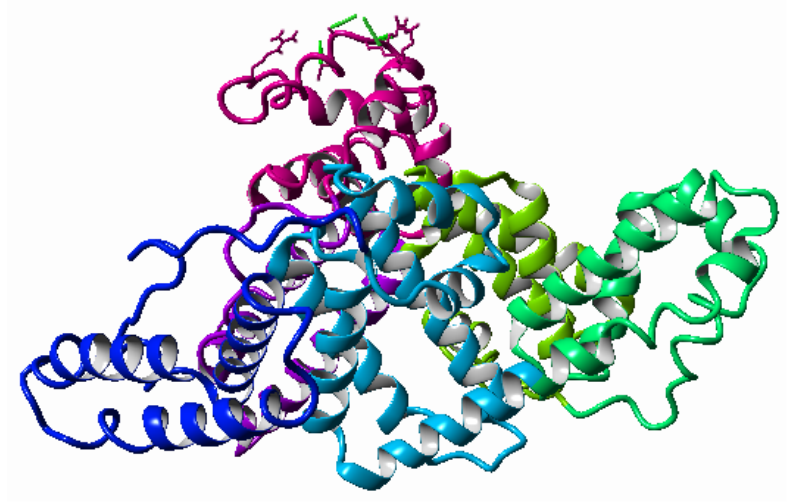
Figure 2. Ribbon representation of albumin in YASARA. Albumin domains are colored as follows: IA-pink, IB-violet, IIA-light green, IIB-green, IIIA-light blue,and